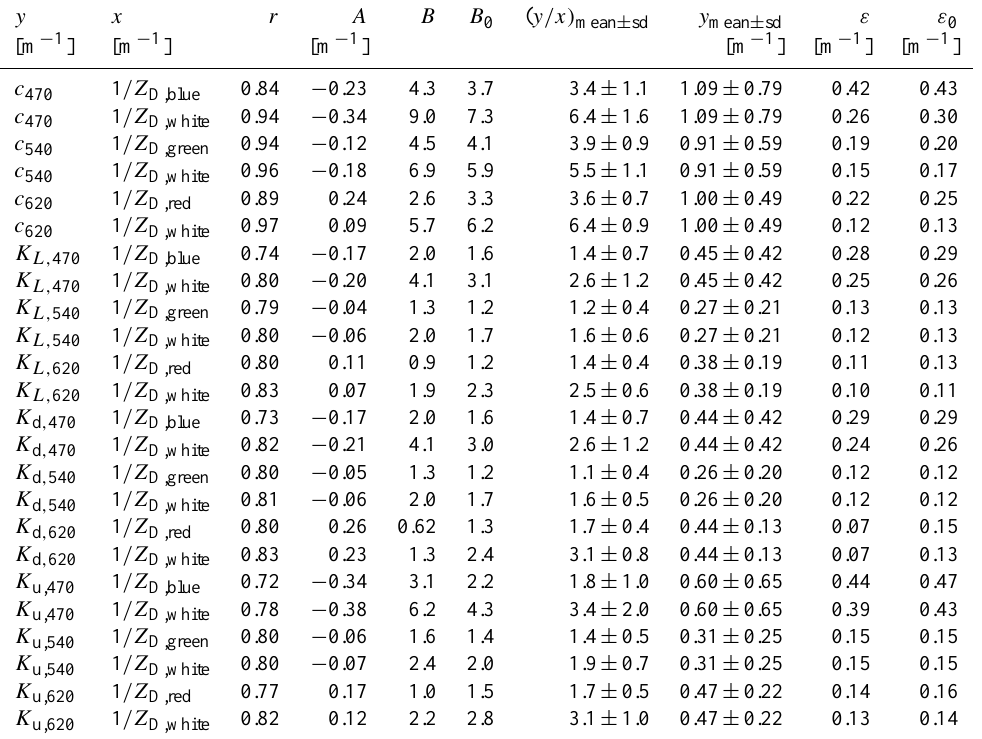
Table 7. Relationships of the forms y = A + Bx and y = B 0 x obtained by correlation analysis of attenuation coefficients of monochromatic radiance and irradiance and Secchi depths observed with the open eye and with blue, green and red glass filters. The attenuation coefficients are averages over the depth range 0– Z D,white , and r is the correlation coefficient. The error ε is the root mean square of the